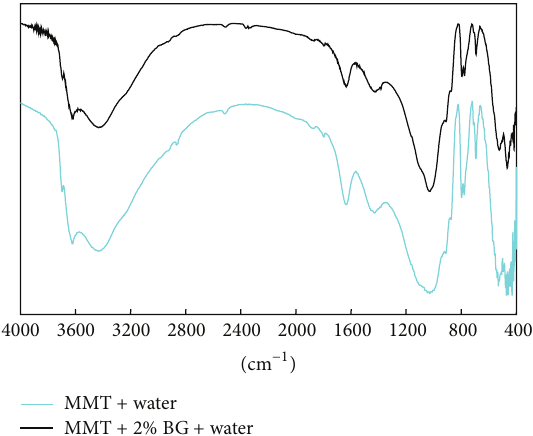
Figure 7: The FT-IR of the montmorillonite treated by water and BG solution.